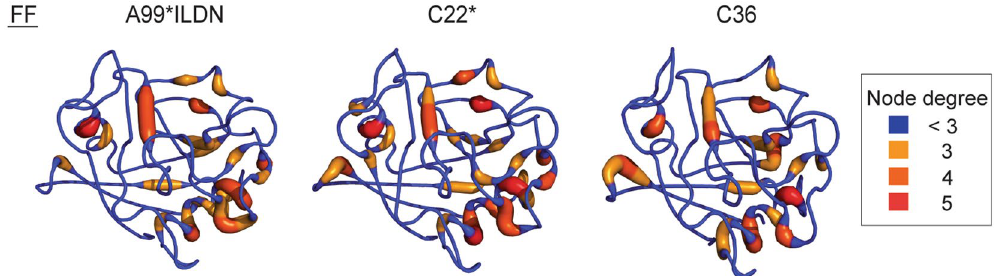
Figure 5. Location of the hub residues on the 3D structure of CypA. We mapped on CypA 3D structure the PSN hubs identified in CypA MD simulations with the three different force fields CHARMM22 * (C22 * ), CHARMM36 (C36) and Amber99SB * -ILDN (A99 * ILDN). The different colors and sizes represent the node degree, i.e. the number of edges for each